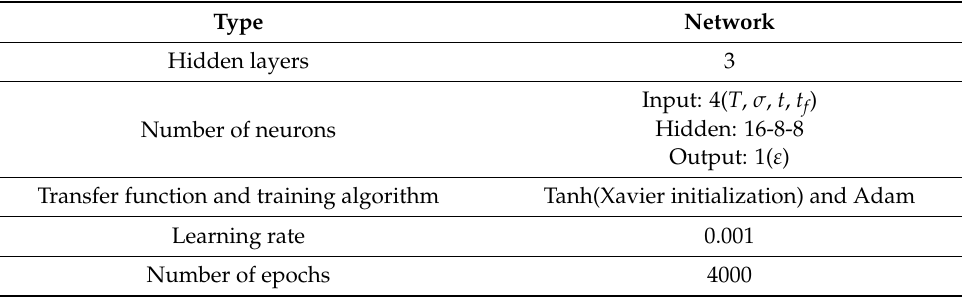
Table 2. The parameters of the BPNN model in this